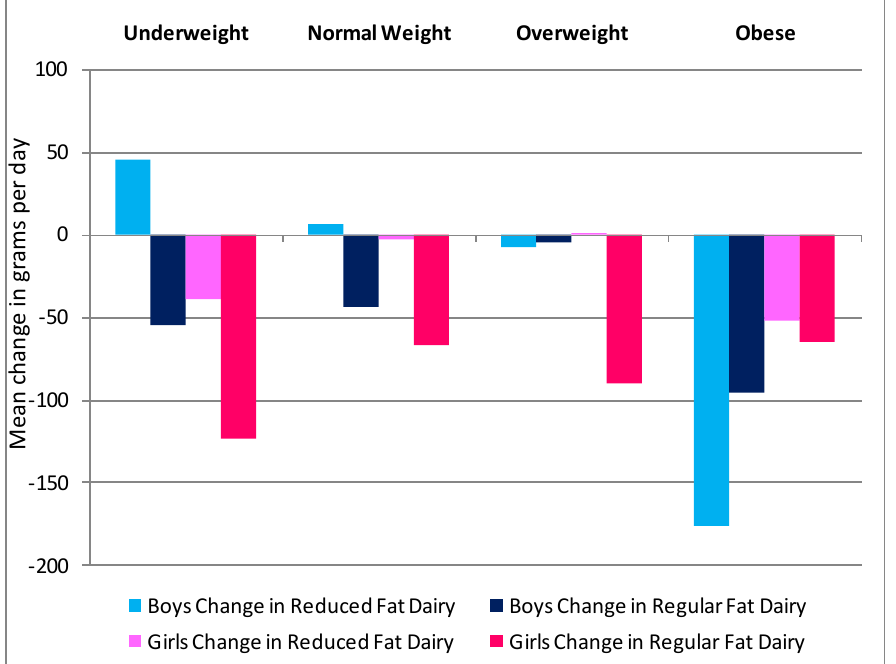
Figure 2. Mean change in grams of total, reduced fat and regular fat dairy in grams per day in Raine Study participants from 14 to 17 year follow-ups, split by body mass index (BMI) categories at 14 years [28,29].